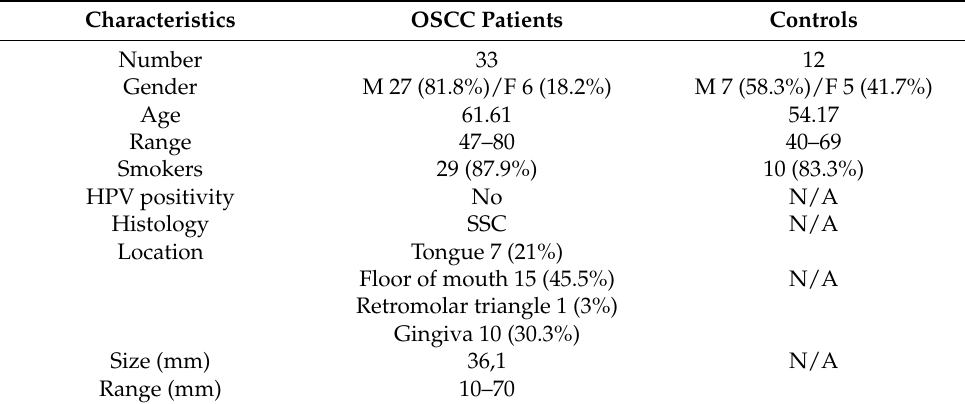
Table 1. Characteristics of OSCC UHSG cohort and controls included in the